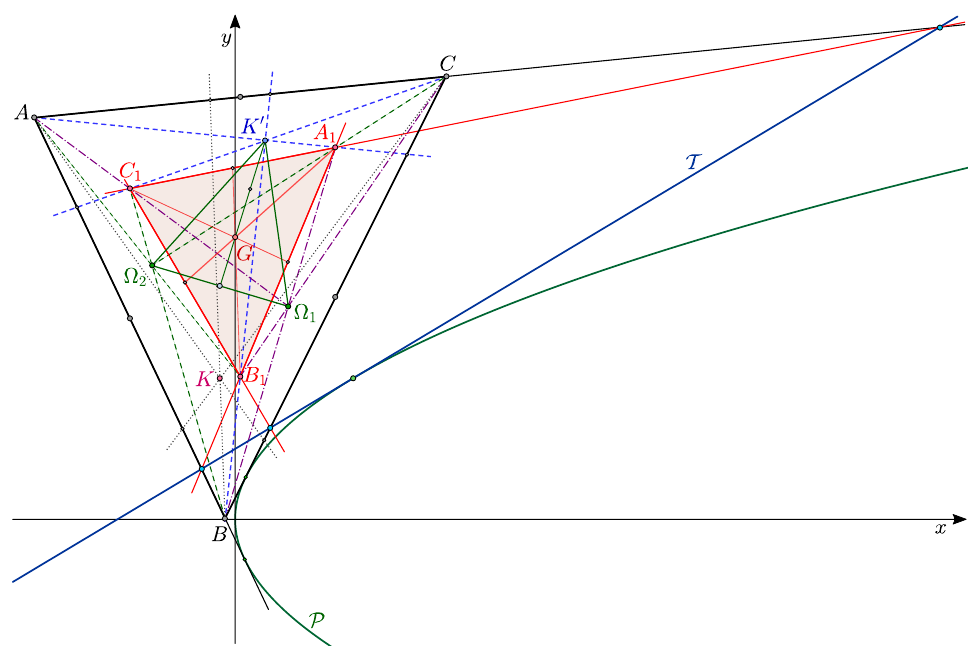
Figure 2. The axis of homology T of the triangle ABC and its first Brocard triangle A 1 B 1 C 1 , and the Kiepert parabola P of the triangle ABC . Visualization of statements of Theorems 5 and